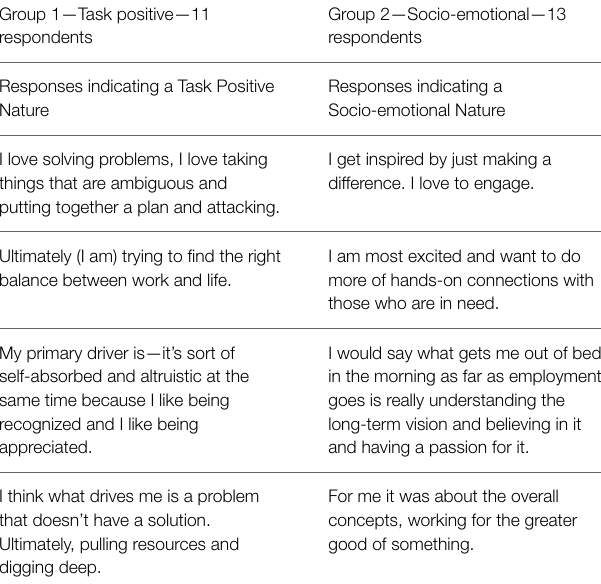
TABLE 1 | Sample responses by group. Group 1—Task positive—11 respondents Responses indicating a Task Positive Nature